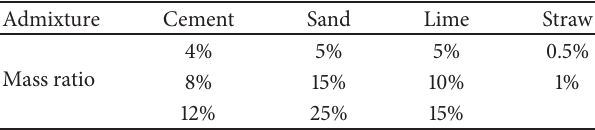
Table 1: Mass ratio of additives in specimens.